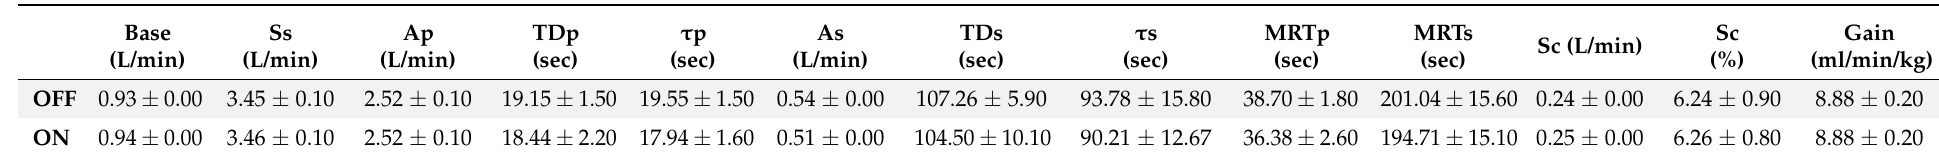
Table 1. Mean values ( ± SEM) of VO2 on-kinetics recorded during constant load exercise in both conditions (PEMF OFF; PEMF ON). Base, baseline; Ss, steady-state; Ap, amplitude of primary component; TDp, time delay for primary component; τ p, tau for primary component; As, amplitude of slow component; TDs, time delay for slow component; τ s, tau for slow component; MRTp, mean response time for primary component; MRTs, mean response time for slow component; Sc, magnitude of slow component.